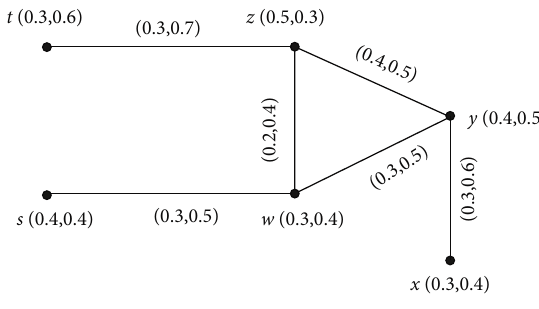
Figure 9: Connected vague graph ζ . Table 2: Weight of nodes.